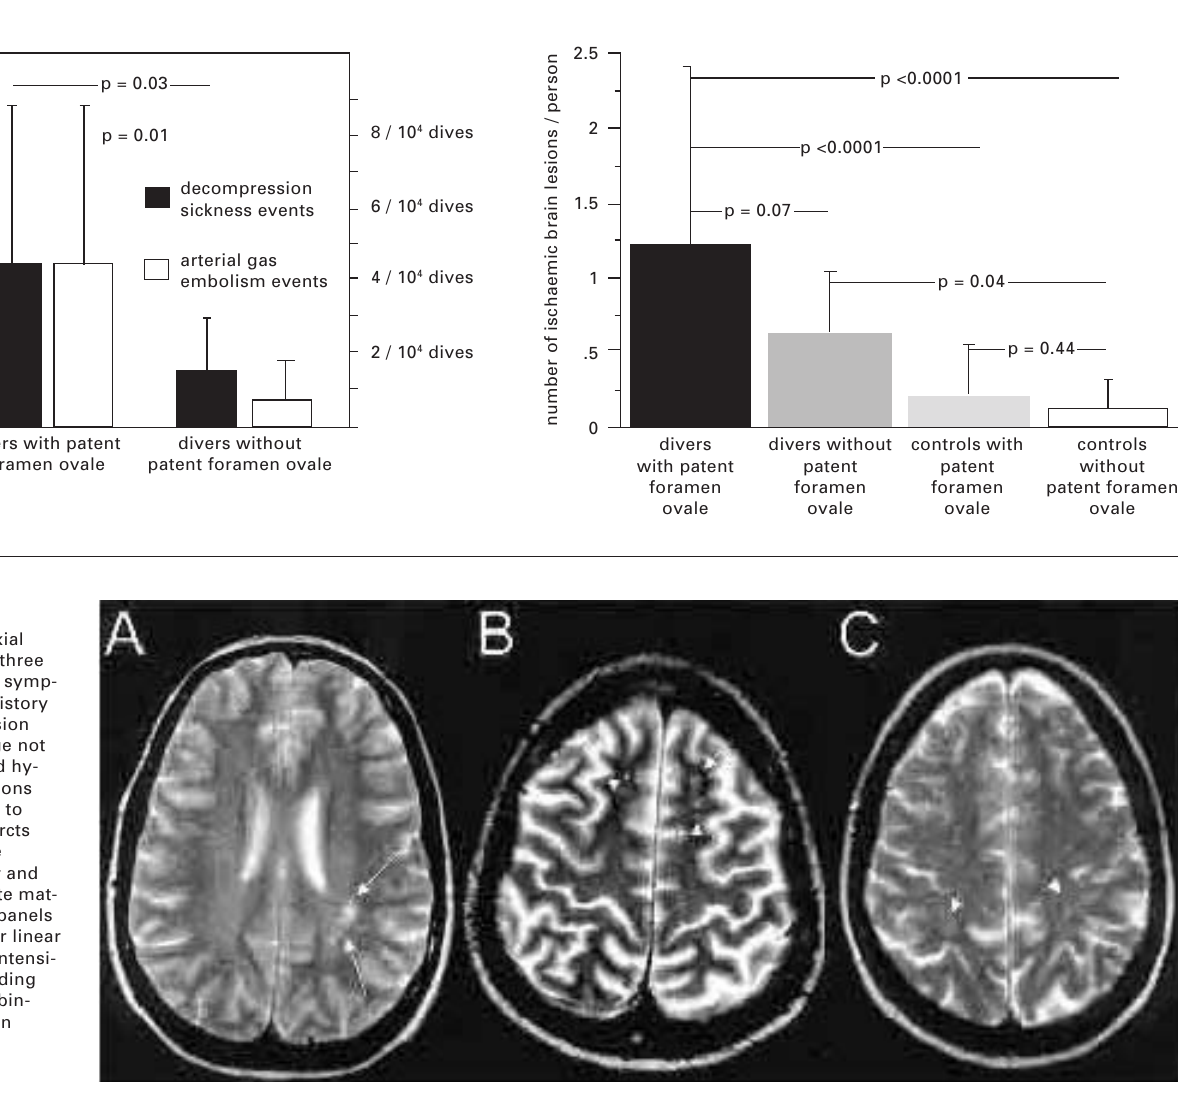
Panel A: The average number of predominantly decompression sickness or arterial gas embolism events per divers (vertical axis, left side) and of decompression sickness events per 10’000 dives (vertical axis, right side) is shown for divers with and without PFO, respectively. Panel B: The average number of ischaemic brain lesions per person depicted by MRI (vertical axis) is shown for the different study groups (horizontal axis). Data from [66], reprinted with the permission from the American College of Physicians – American Society of Internal Medicine. Abbreviations : PFO: patent foramen ovale.